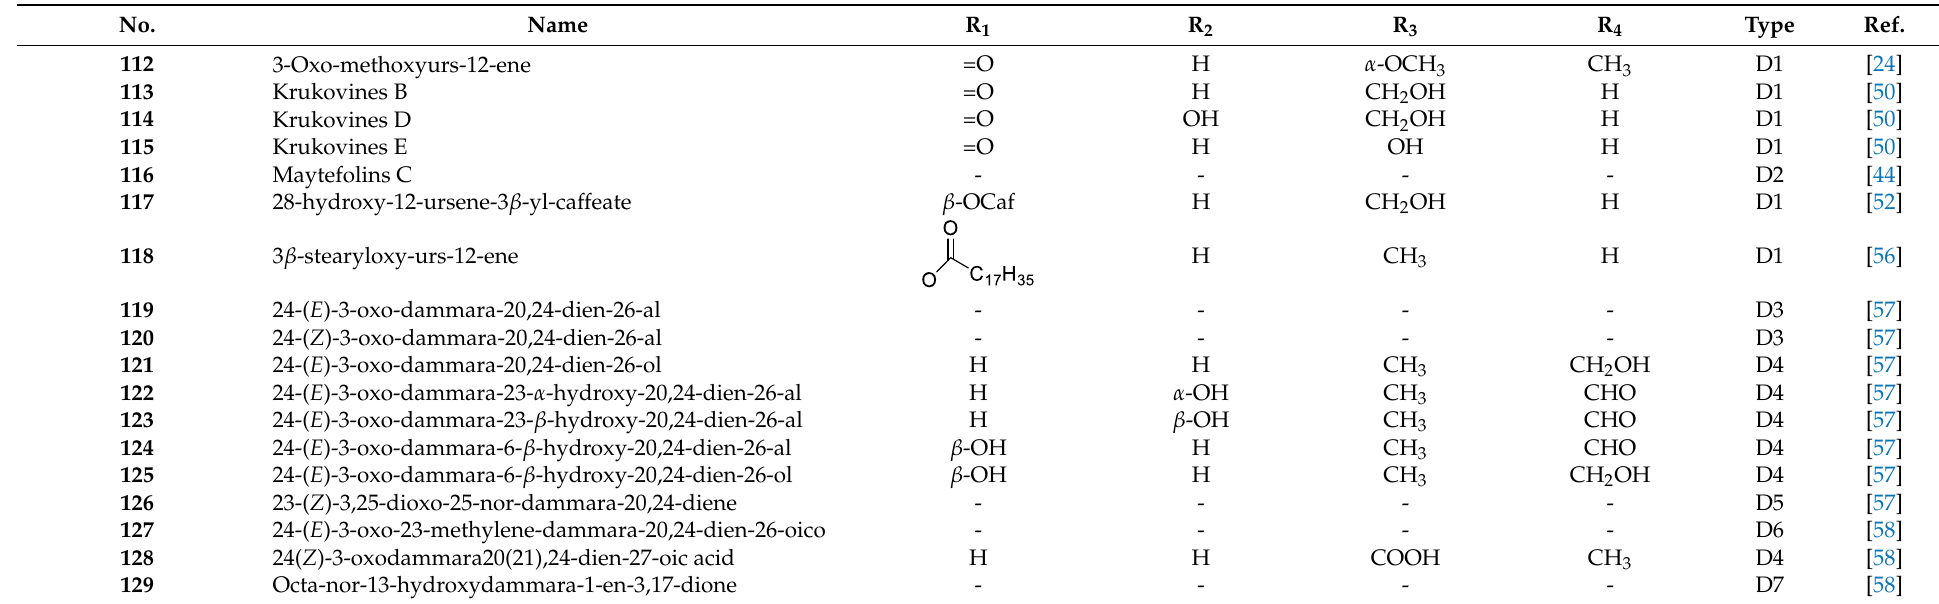
Table 4. The other triterpenes isolated from Maytenus .